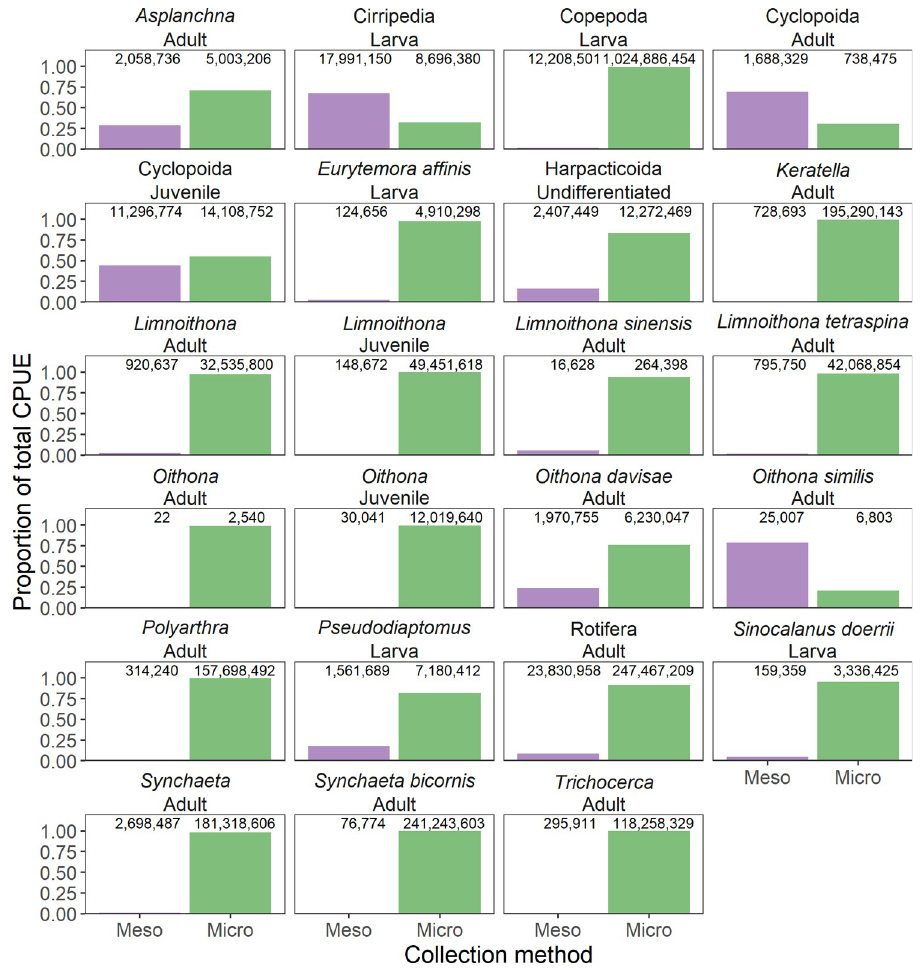
Fig 4. Relative catch reported from two different collection methods. The relative catch was calculated using data from the Environmental Monitoring Program (EMP): the ‘Meso’ (Mesozooplankton, 153 μ m mesh, net) vs ‘Micro’ (Microzooplankton, 43 μ m mesh, pump) sampling methods, for taxa counted in both. We did not compare the catch- efficiency of each gear type, our intent was to assess the reliability of data reported by each gear type to inform analyses of these data. Higher taxonomic levels (above species) represent “other” categories and do not include counts from the lower taxa they contain (e.g., Synchaeta Adult does not contain counts of the individuals from Synchaeta bicornis Adult). Numbers above bars indicate the total